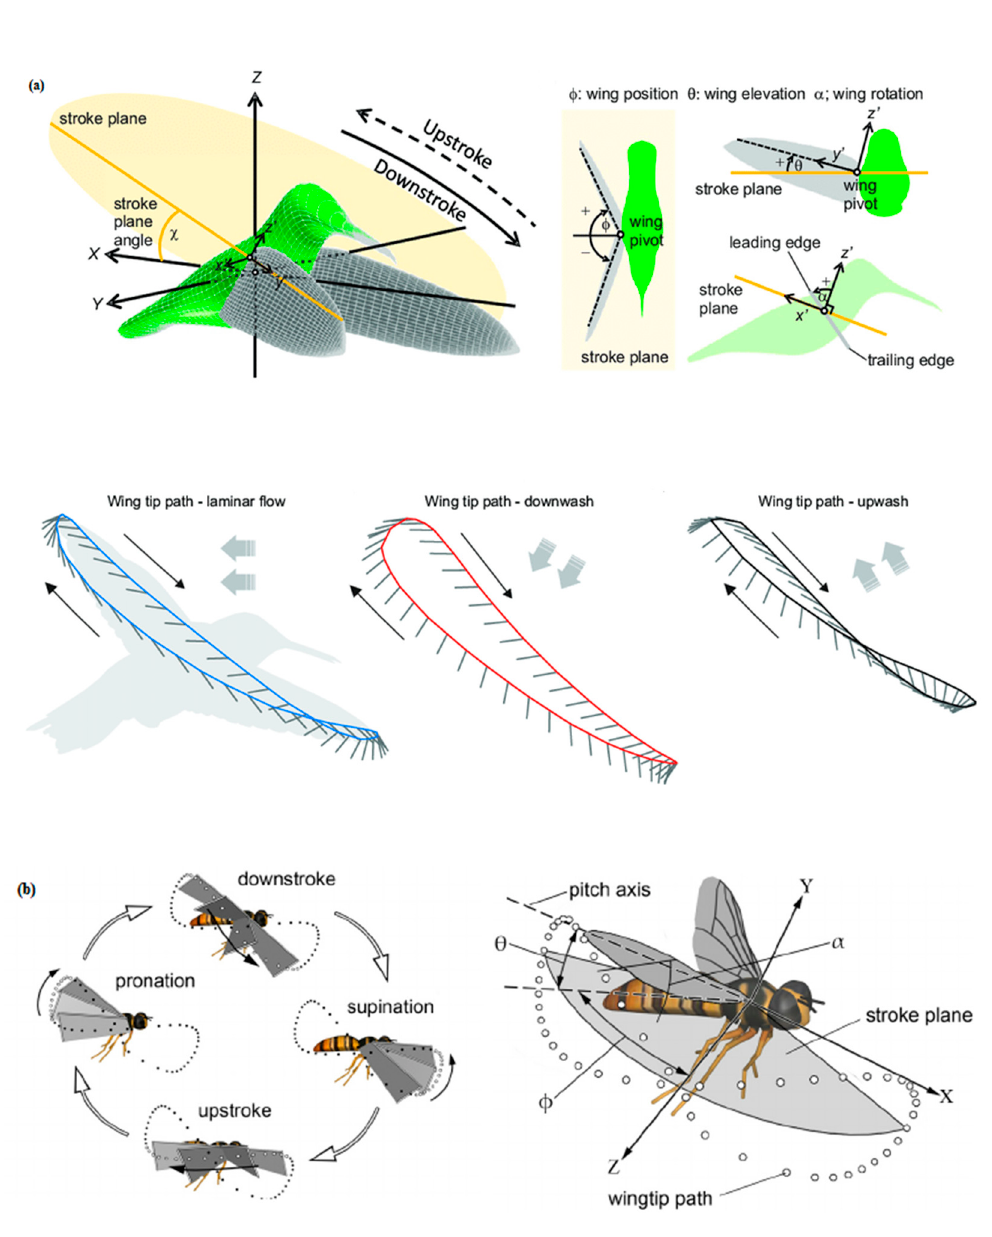
Figure 3. Wing kinematics and aerodynamics of ( a ) hummingbird (reprinted from [71] with permission from Elsevier) and ( b ) insect flight (adapted from [72]).